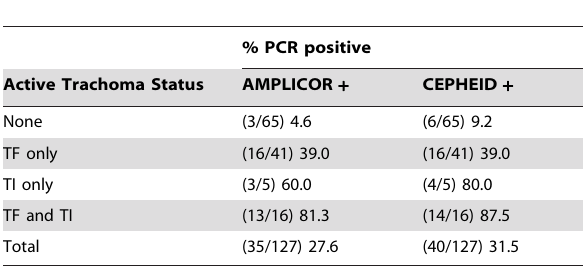
Table 2. Trachoma status and infection positive results according to the two tests.